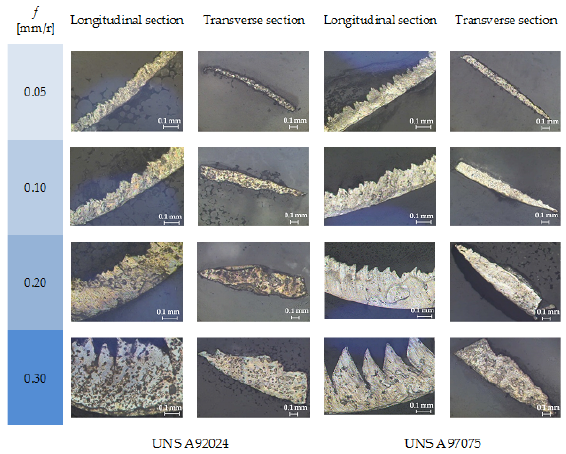
Figure 6. SOM images of the chip’s longitudinal (200×) and transverse (100×) section.